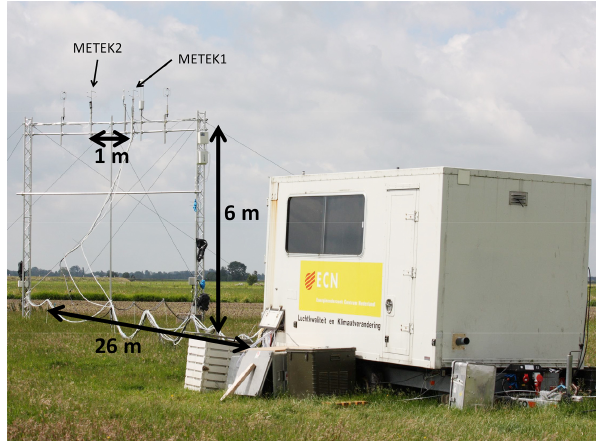
Figure 1. Picture of the measurement setup. The picture was taken towards the most common wind direction during the campaign. The trailer which housed the closed-path instruments and data-logging computer is at the front of the